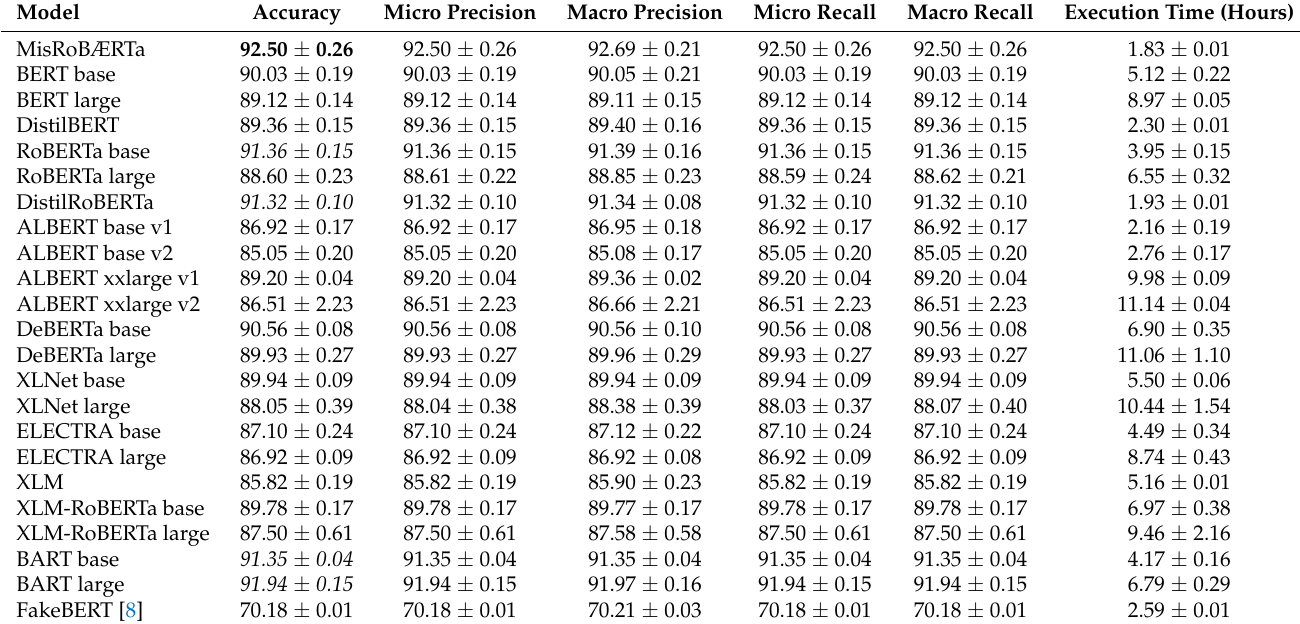
Table 6. Misinformation classification results (note: italic text marks similar results while bold text shows the overall best